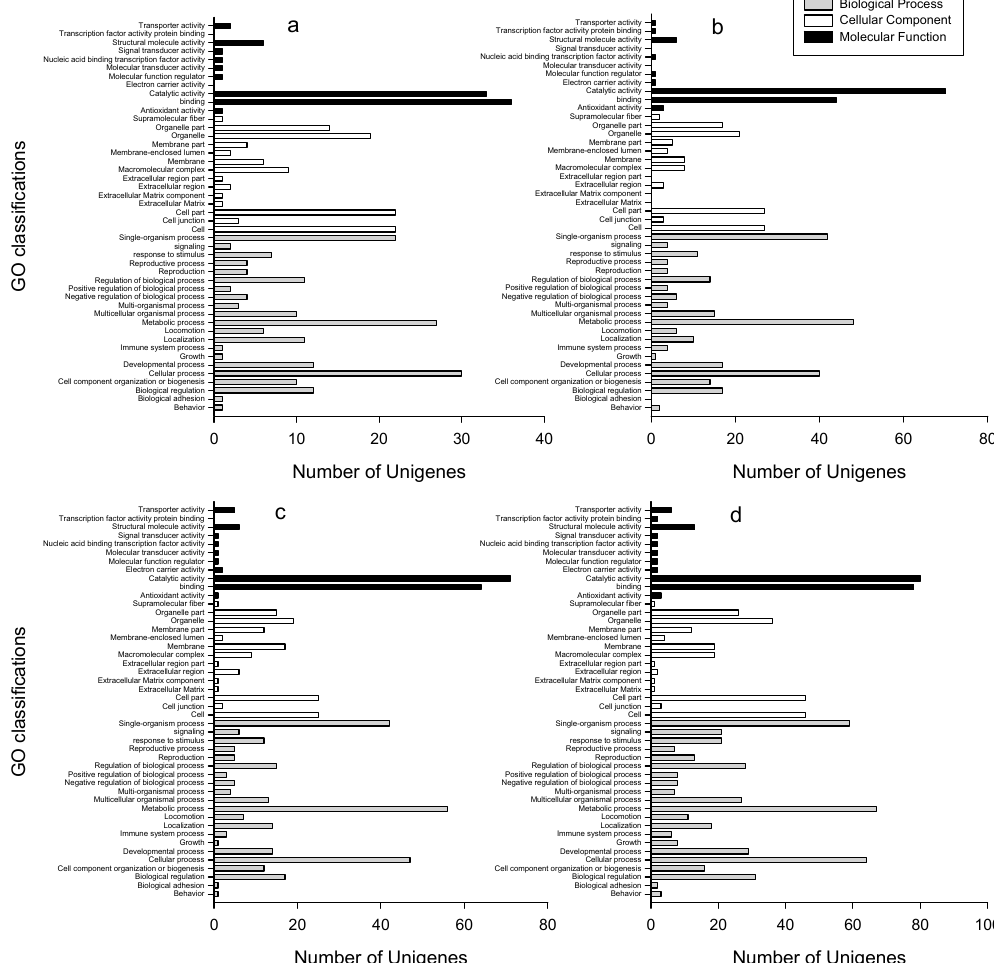
Figure 4. Number of DEUs classified into the Gene Ontology (GO) function catalogue using different insecticides and different time durations in comparison with control. ( a ) treatment with Chlorpyrifos for 6 h versus control, ( b ) treatment with Chlorpyrifos for 48 h versus control, ( c ) treatment with Clothianidin for 6 h versus control, ( d ) treatment with Clothianidin for 48 h versus control.